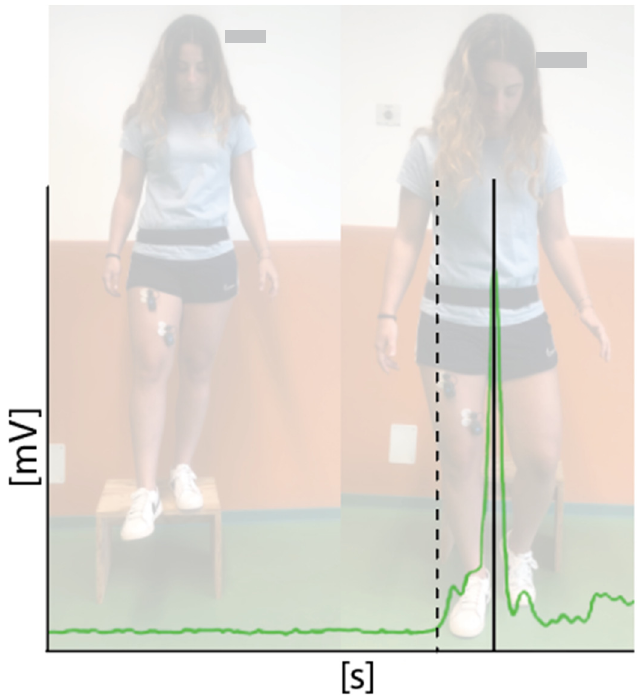
Figure 1. sEMG signal of vastus medialis (green line) of one athlete. Pre-activation time is measured as the interval time between the activation of the muscle (dashed line) and the floor contact.